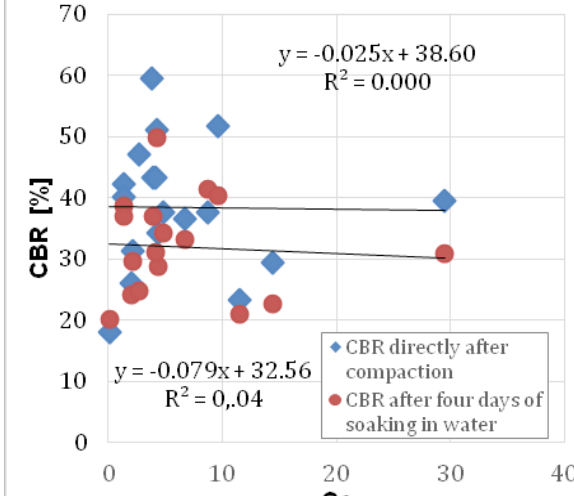
Figure 6: Correlation between CBR value and coefficient of gradation C C